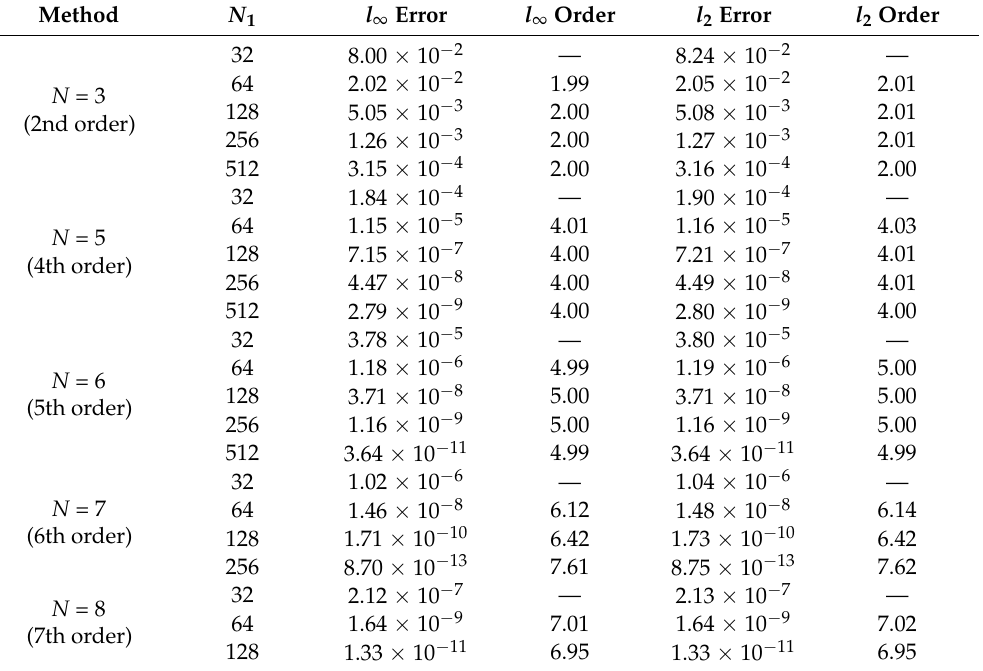
Table 2. Numerical results for the sine wave